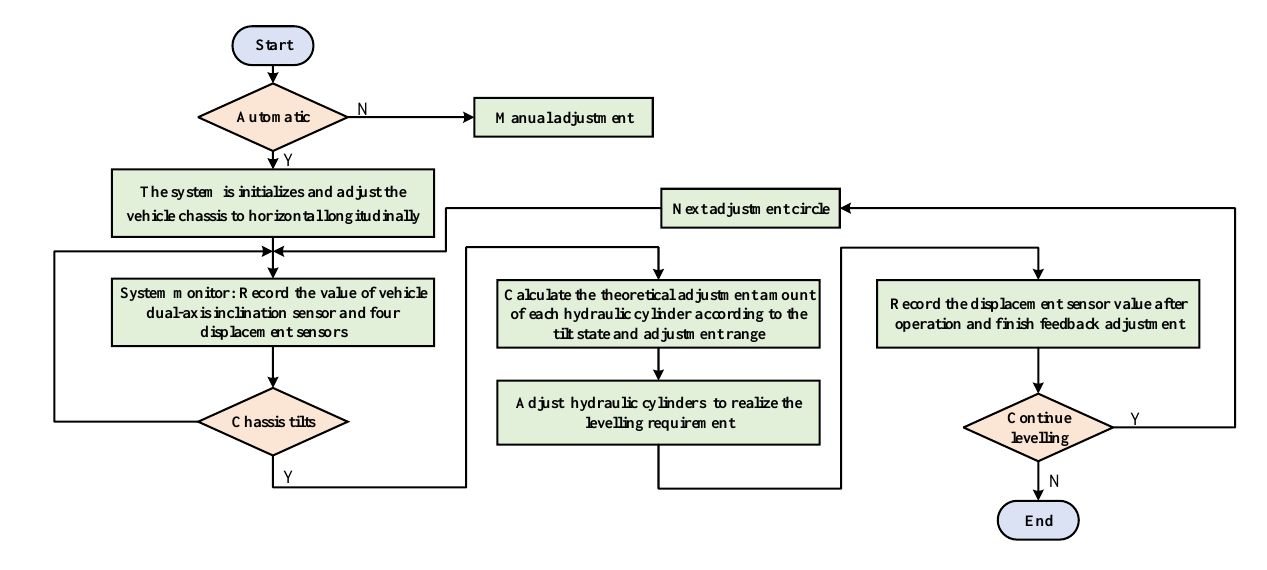
Figure 3. Main working procedure of the adaptive leveling system.